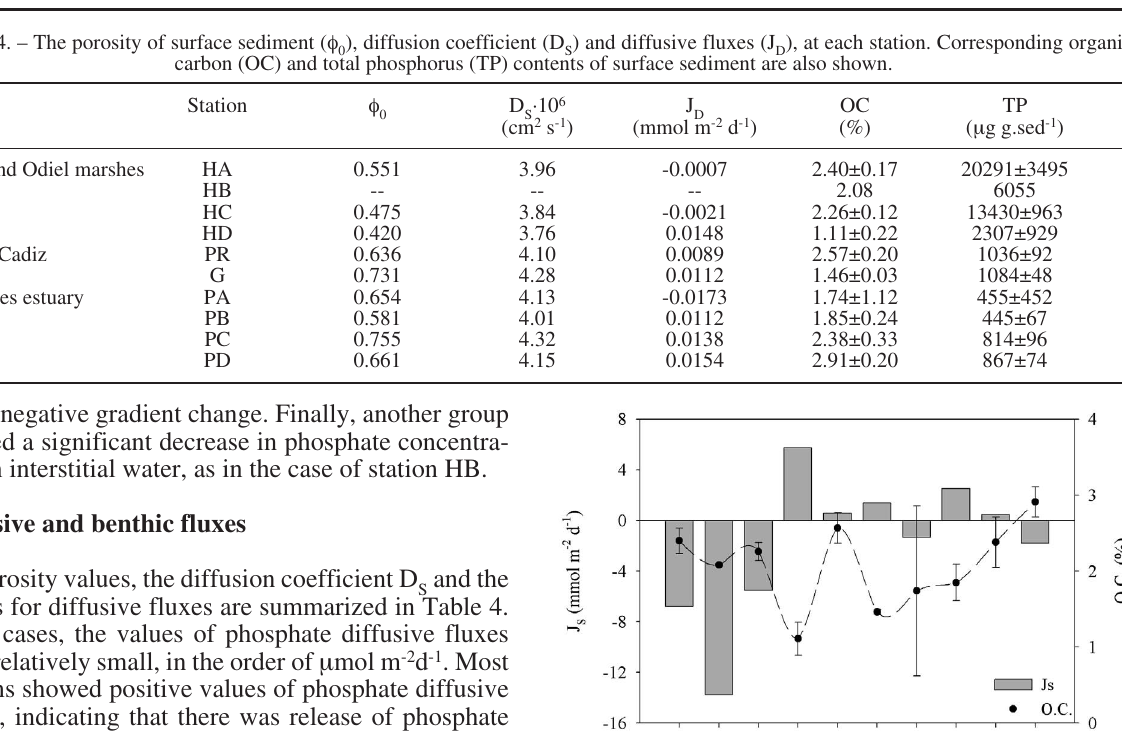
) and organic carbon con- S